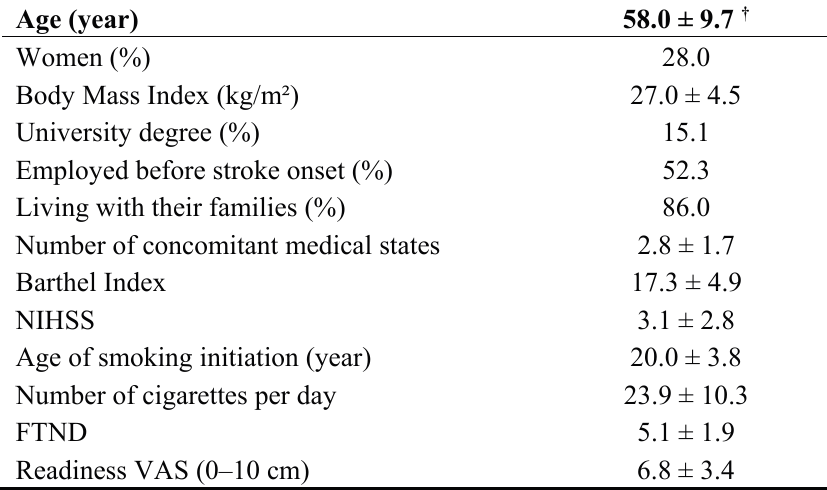
Table 1. Baseline characteristics of 86 smokers with first-ever ischemic stroke *